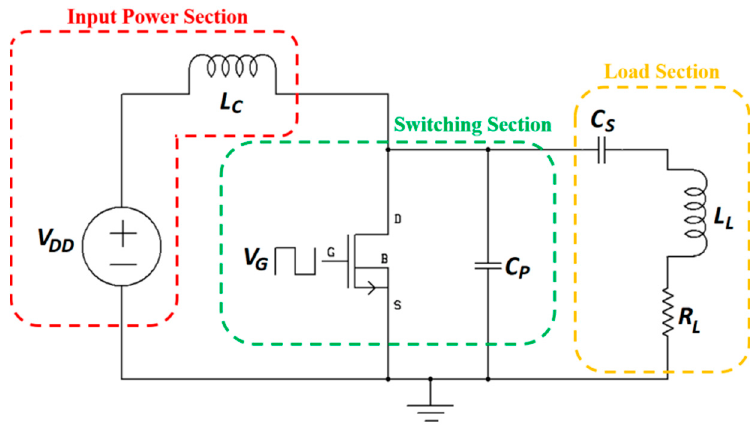
Figure 6. Single-ended class-E power amplifier (PA) for NRIC WPT.